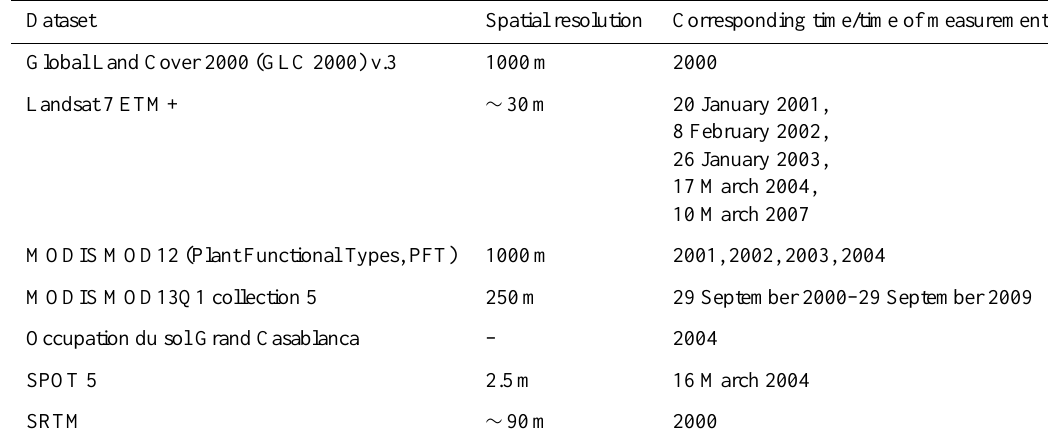
Table 1. Overview of data used.